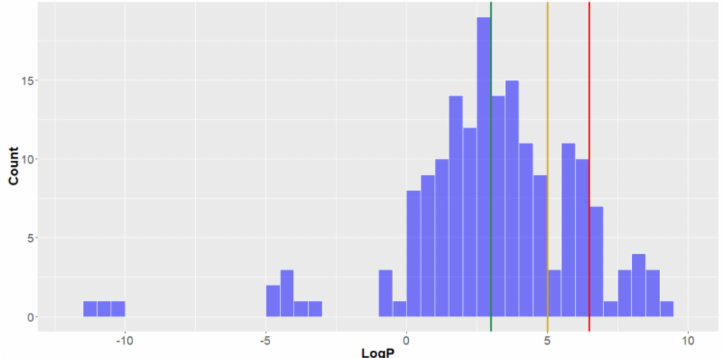
Figure 7. The statistical distribution of the octanol—water partition coe ffi cient (LogP) of all analysed compounds (green = 3, compounds < 3 are in the lead-like space; yellow = 5, compounds < 5 are in the drug-like space; red = 6.5, compounds < 6.5 are in the KDS. Total number of compounds = 179.